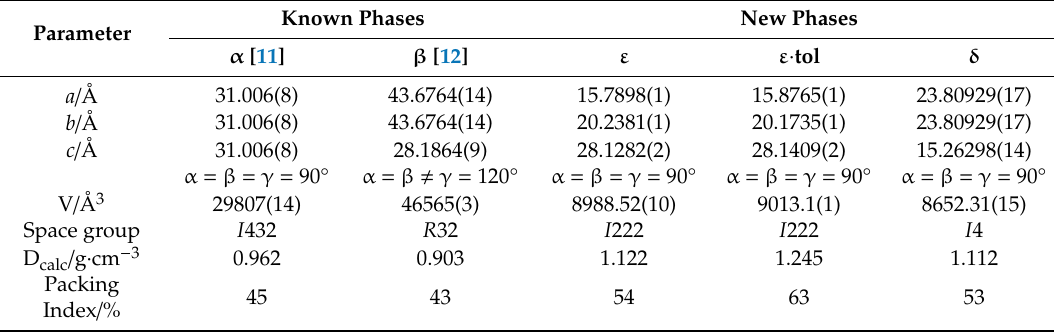
Table 1. Crystallographic data and structure refinement details for crystal phases of γ